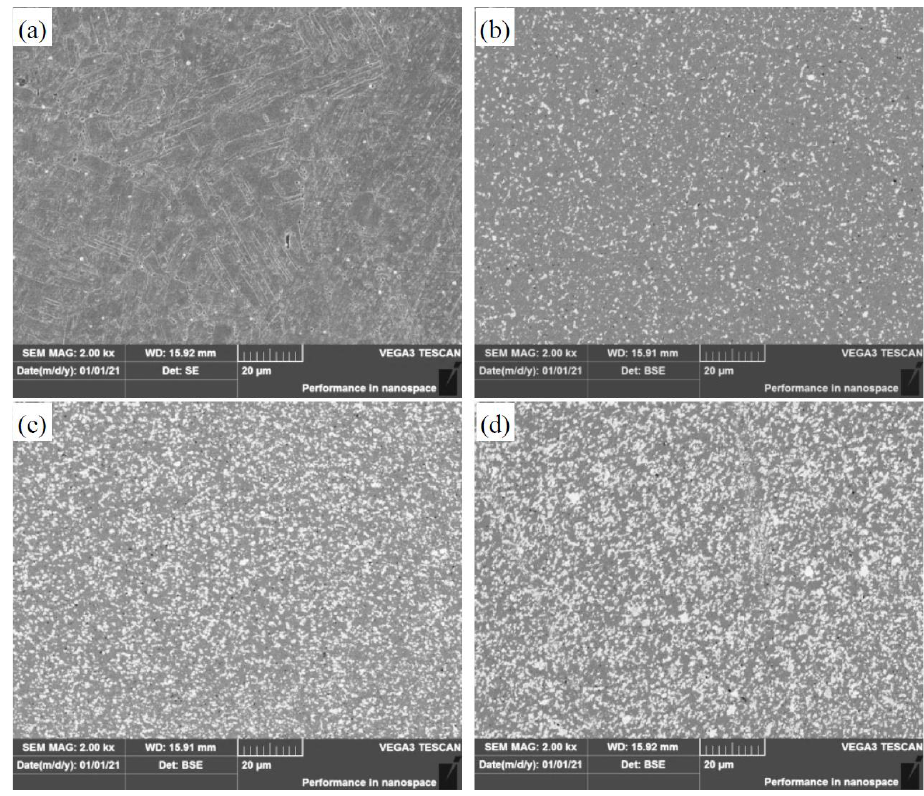
Figure 4. Microstructure of Cu-W composites with different W contents: ( a ) Cu; ( b ) Cu-10 wt% W; ( c ) Cu-20 wt% W; ( d ) Cu-30 wt% W.